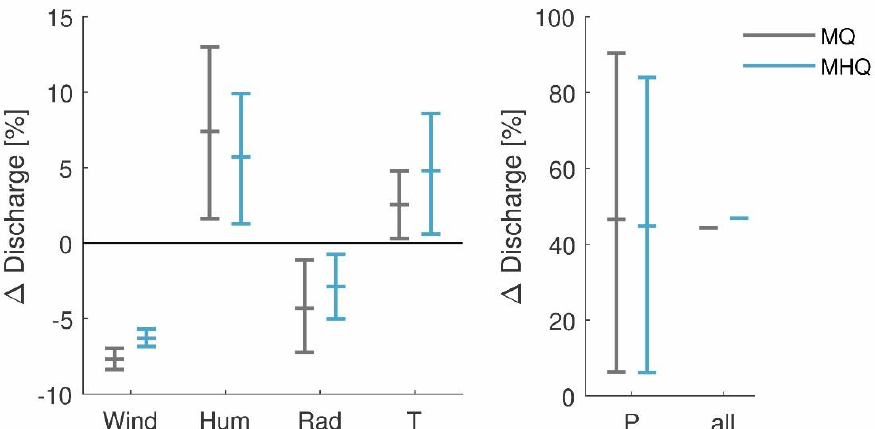
Figure 3. Result of the sensitivity analysis for climate variables. The bars represent the deviations in MQ and MHQ for the simulation runs with altered climate variables (Wind = wind speed, Hum = relative humidity, Rad = global radiation, T = temperature and P = precipitation) according to the three sensitivity levels compared to Q ref .